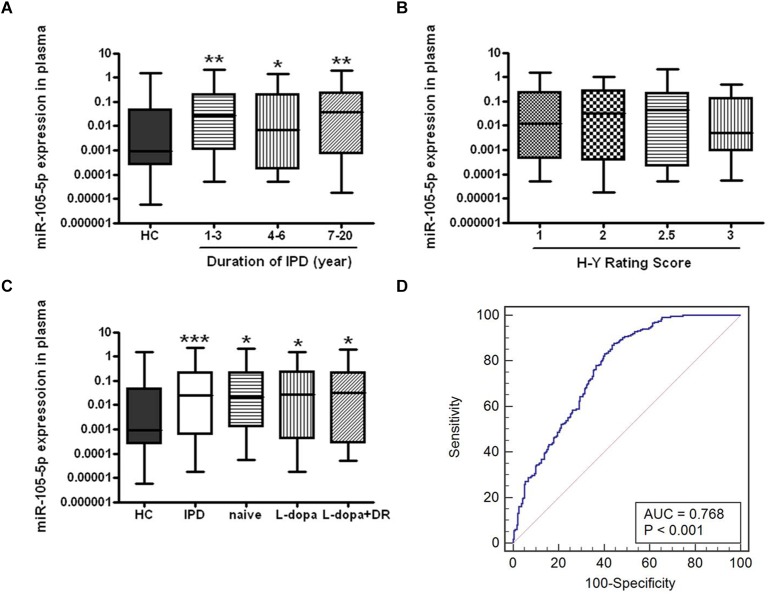
The expression level of miR-105-5p in IPD and HC. The effects of (A) disease course, (B) severity, and (C) anti-PD medications to the expression level of miR-105-5p. (D) ROC curve for miR-105-5p between PD and HC. The areas under the ROC curve (AUC) were 0.768 (95% CI, 0.727–0.805; P < 0.001). Whiskers in the box plots represent minimum to maximum value. The center line in the box represents the median value. Non-parametric ANOVA test, ∗P< 0.05 vs. HC, ∗∗P< 0.01 vs. HC, ∗∗∗P< 0.001 vs. HC.